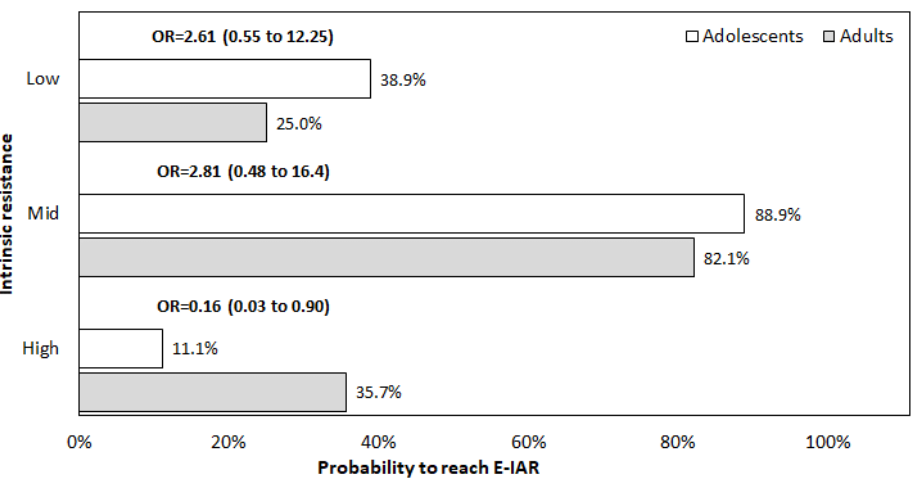
Figure 1. Proportion of subjects who reached their E-IAR value at the three simulated regimens. E- IAR: expected inspiratory airflow rate; OR: odds ratio adjusted for RV and I Raw .